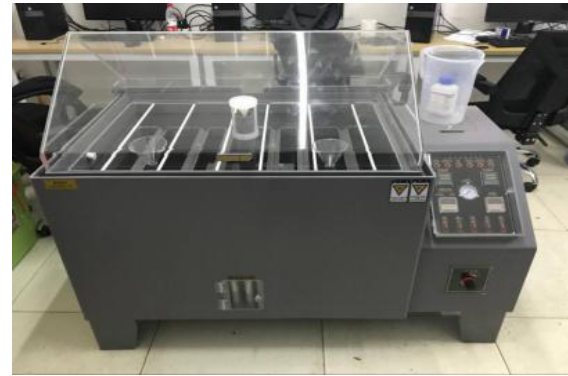
Figure 6. Salt fog corrosion chamber.